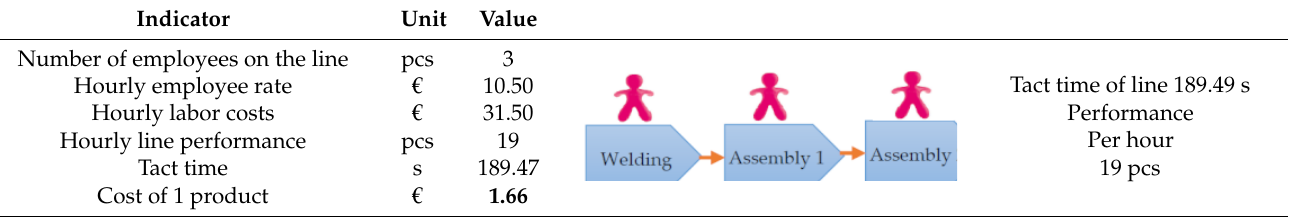
Table 10. Calculation of labor costs per product when measuring the number of finished products of the production